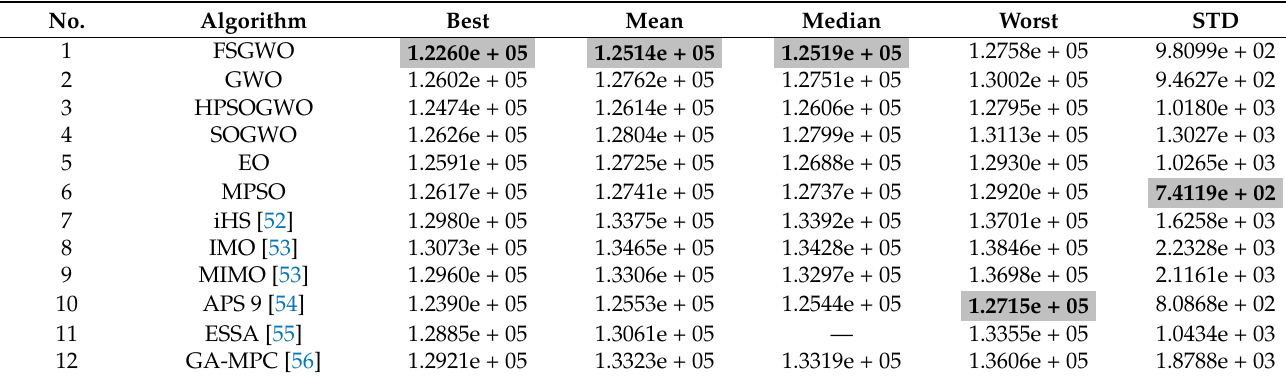
Table 12. Results of the related algorithms for the 40-unit ELD